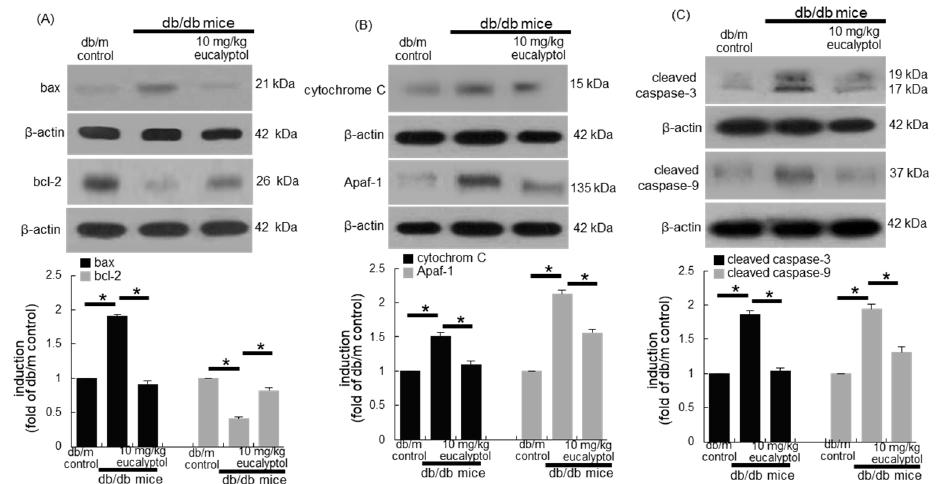
Figure 4. Inhibitory effects of eucalyptol on retinal apoptosis in diabetic eyes. Retinal cortical tissue extracts were subject to western blot analysis with a primary antibody against bax, bcl-2, cytochrome C, Apaf-1, cleaved caspase-3, cleaved caspase-9 and β -actin for an internal control ( A–C ). The bar graphs (mean ± SEM, n = 3) represent the quantitative results of blots in the panels. * Values in respective bar graphs indicate a significant difference at p < 0.05.